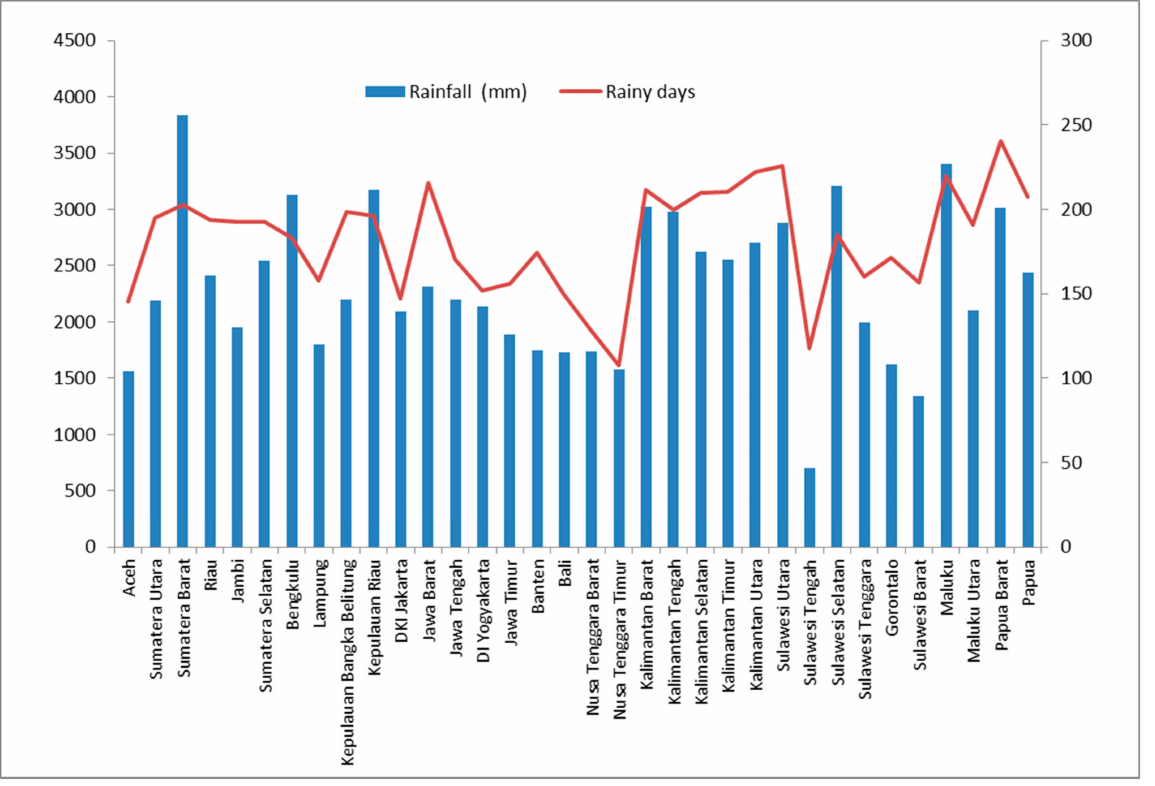
Figure 4. Average rainfall and number of rainy days in Indonesian regions in 2011–2015